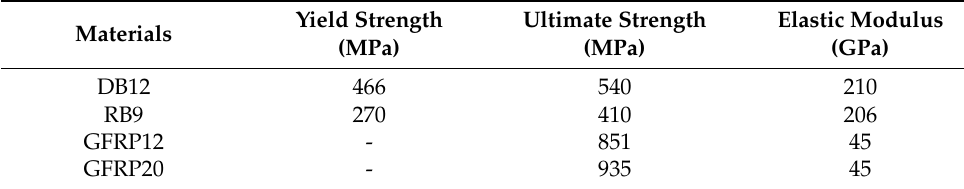
Table 2. Mechanical properties of materials.